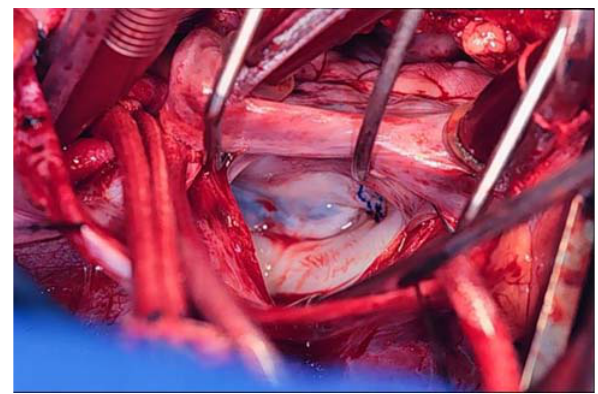
Fig. 2 - Aortic cross clamp using a long curved aortic